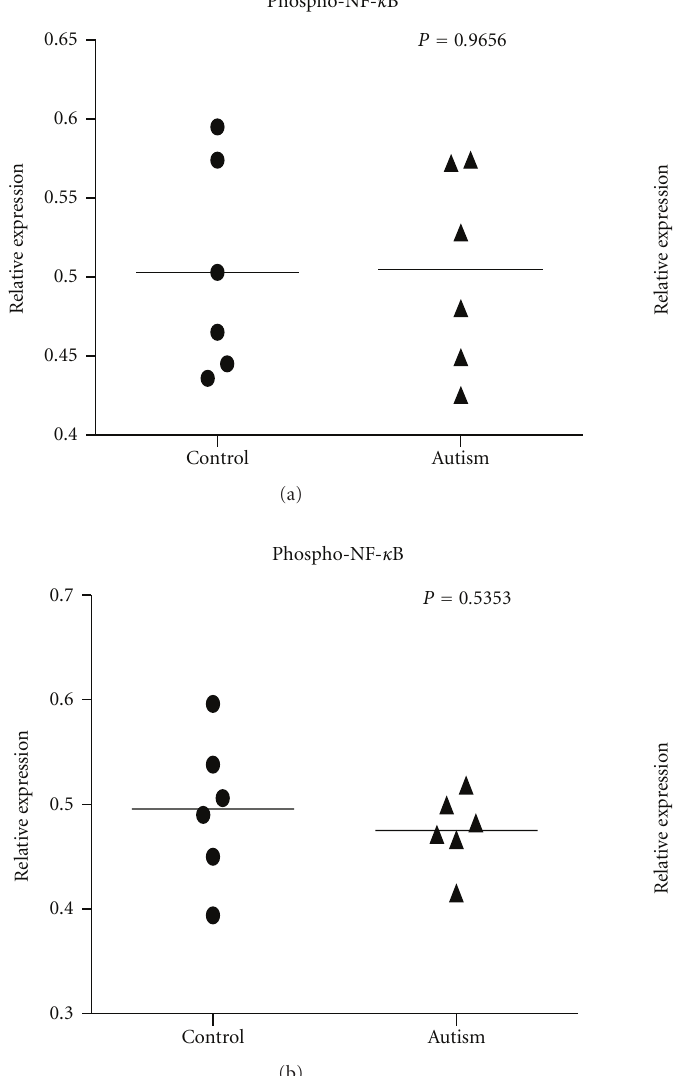
Figure 5: Phospho-NF- κ B p65 concentration in the cerebellum and cortex of BTBR mice. Measurement of phospho-NF- κ B p65 in the cerebellum ((a) P = 0 . 136) and cortex ((b) P = 0 . 968) of six BTBR mice and six age-matched control B6 mice with